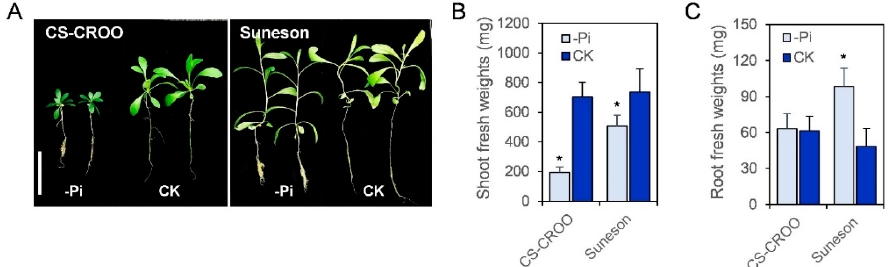
Figure 6. ( A ) Phenotype, ( B ) shoot biomass, and ( C ) root biomass of the low-P-sensitive CS-CROO and the low-P-tolerant Suneson grown under low-P (-Pi, 10 µM) and the control (CK, 312 µM) conditions for four weeks. White scale bar represents 5 cm. The biomass data represents the mean ± SD of one of the three experiments ( n = 10). Asterisk indicates a significant difference (* p < 0.0005) between -Pi and CK conditions.